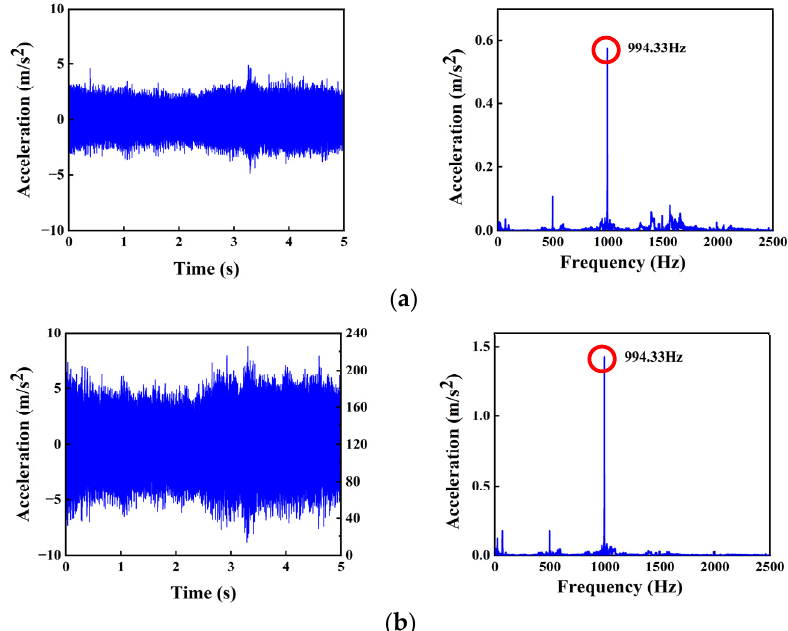
Figure 7. Time domain and frequency domain of vibration acceleration at 40 km/h maglev train speed: ( a ) lateral and ( b ) vertical.